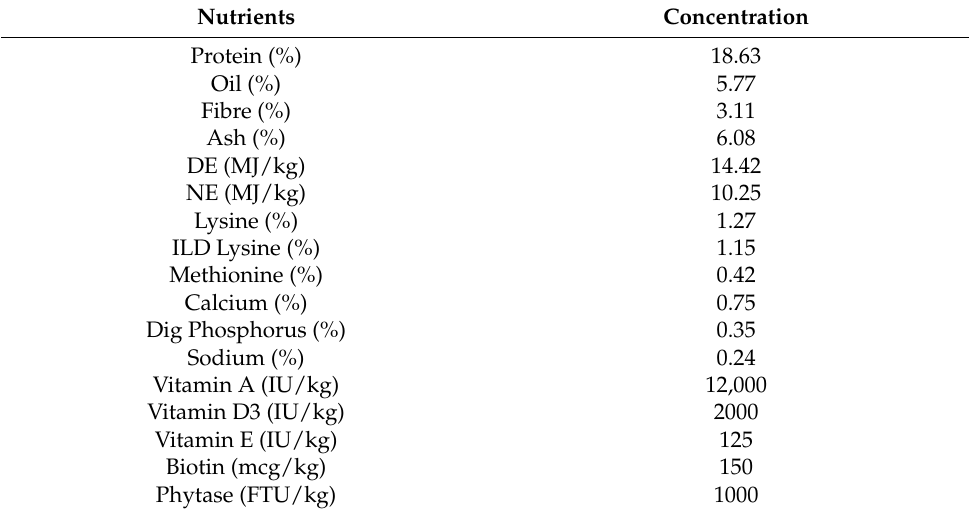
Table 1. Diet formulation for weaner pigs.